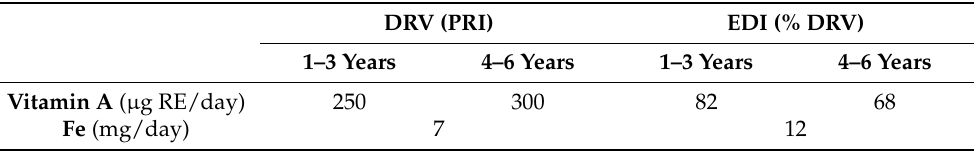
Table 7. Estimated daily intake (EDI), expressed as % of the dietary reference value (DRV) [22], of vitamin A and Fe for children (1–6 years) considering an average per capita nfuma consumption of 100 g/day.